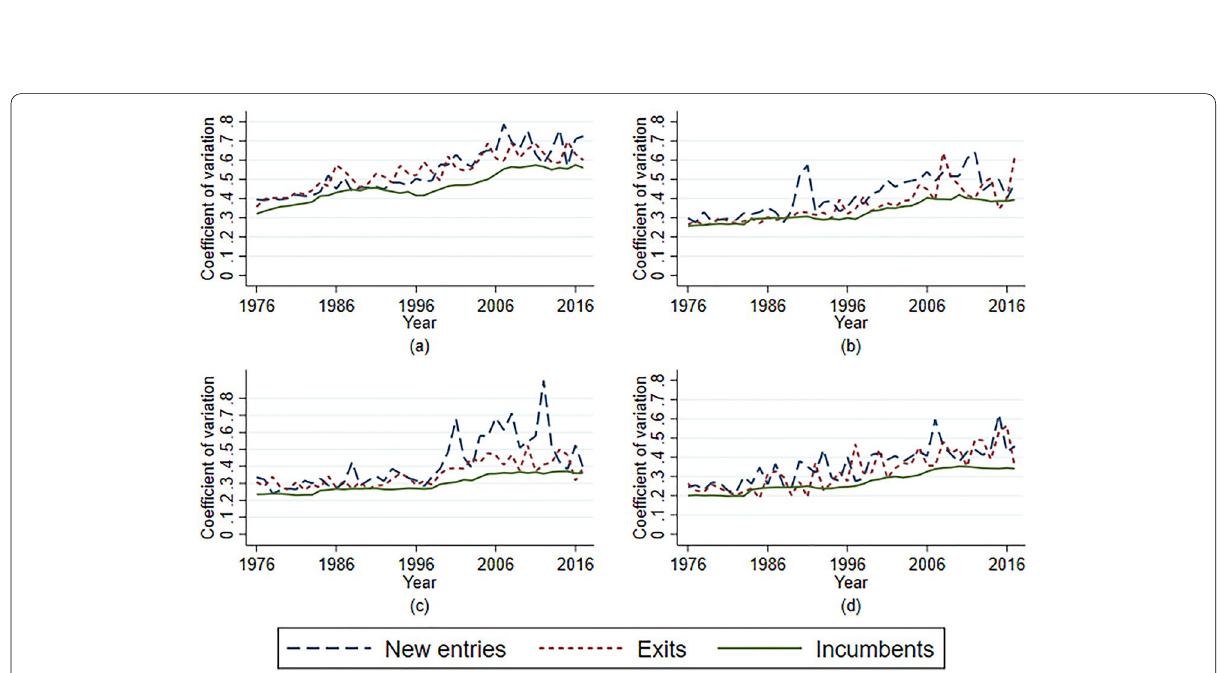
Fig. 14 Coefficient of variation within different establishment size classes for the manufacturing sector. a 1–9 employees, b 10–19 employees, c 20–49 employees, d 50 +